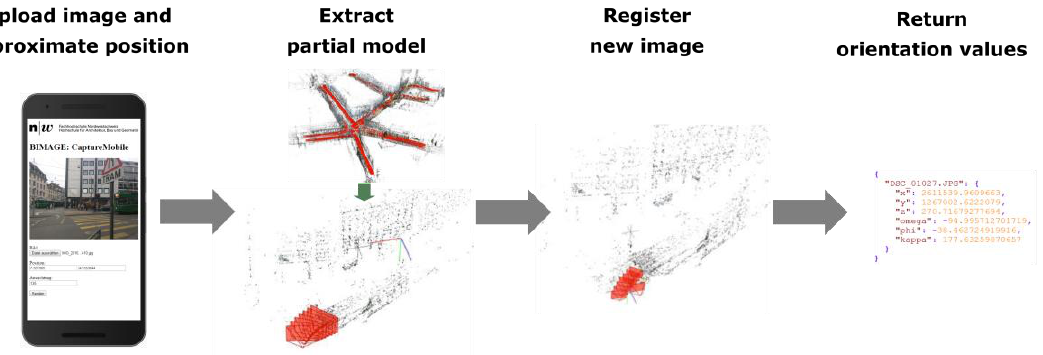
Figure 1. Automated web service-based processing pipeline of our visual localization approach that registers a single image to reference 3D image spaces and thus computes its